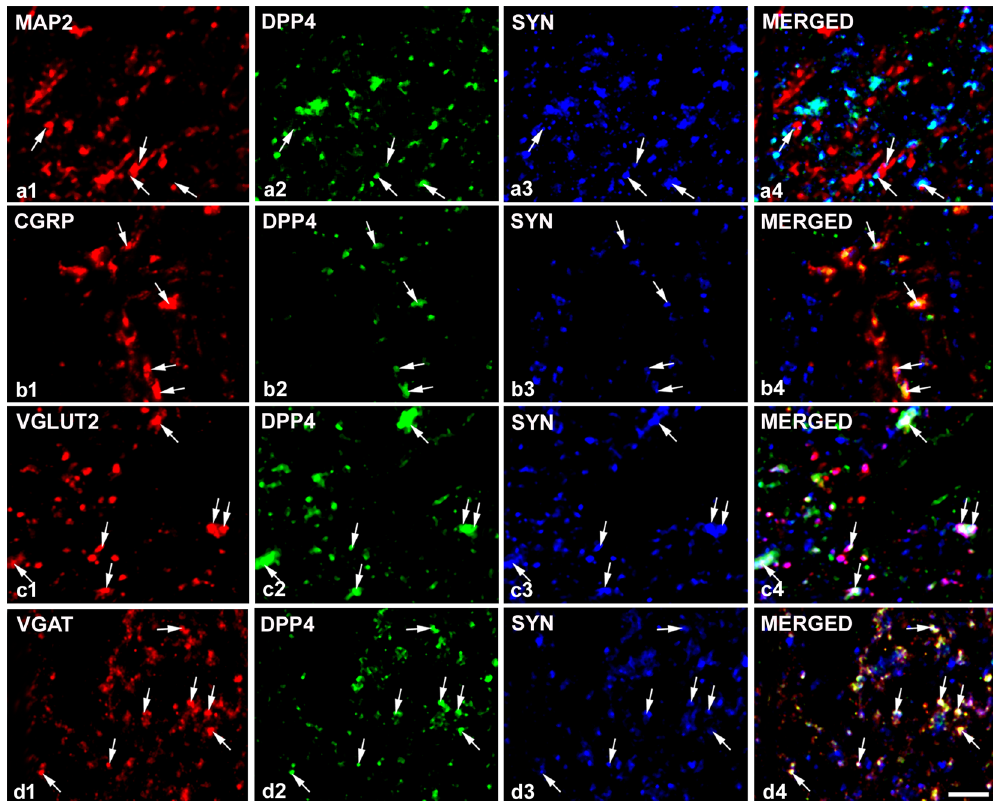
Figure 3. DPP4 immunoreactivity in various types of axon terminals. DPP4 immunolabelling on MAP2- stained dendritic surfaces was associated with synaptophysin (SYN) indicating that not the dendrites but the axon terminals express the receptor (row a). DPP4 is expressed by the majority of peptidergic (CGRP- containing) C primary afferent terminals (row b) and coexpression of DPP4 with SYN and VGLUT2 (row c) or VGAT (row d) suggests that DPP4 is present both in excitatory and inhibitory nerve endings. All the images are single optical sections. Scalebar: 5 μ m.